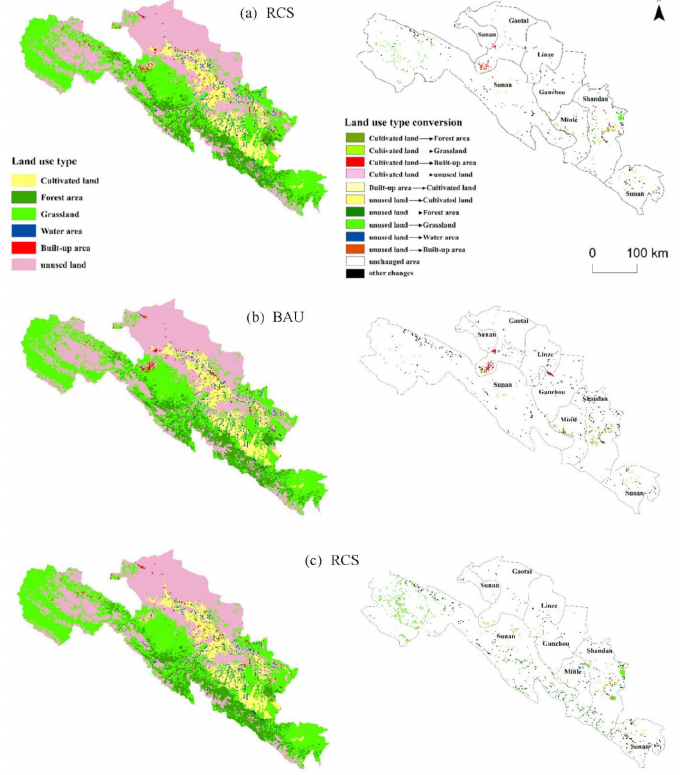
Figure 9. Spatial distribution of land use in Zhangye Ccty in 2030 and land use conversion during 2015–2030 under the ( a ) BAU, ( b ) RCS ( c ) and GDS